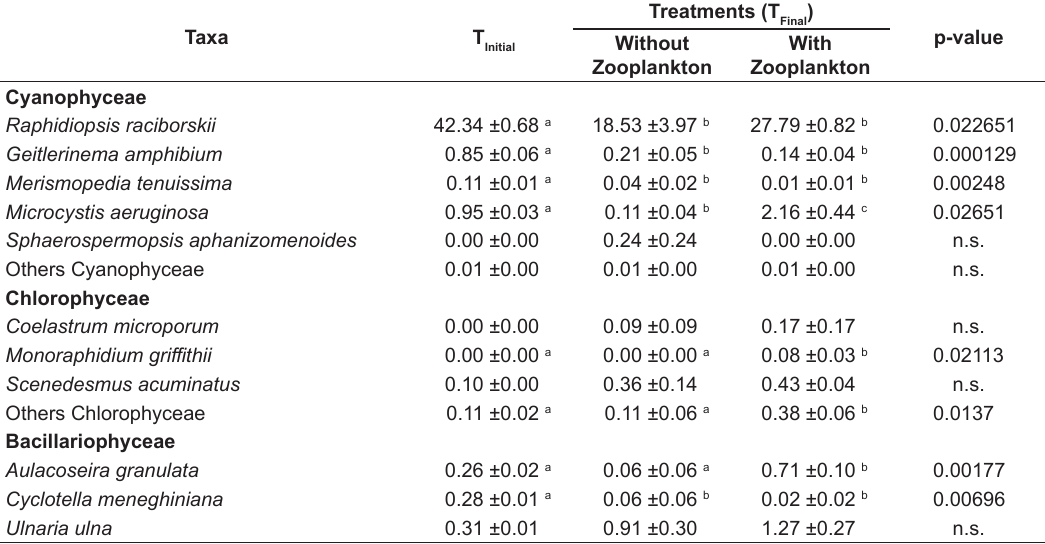
Table 2. Phytoplankton biomass (mg.L -1 ) and standard error of the mean (±SEM) at the beginning of the experiment (T ) and the end of the experiment with and without zooplankton (T Initial